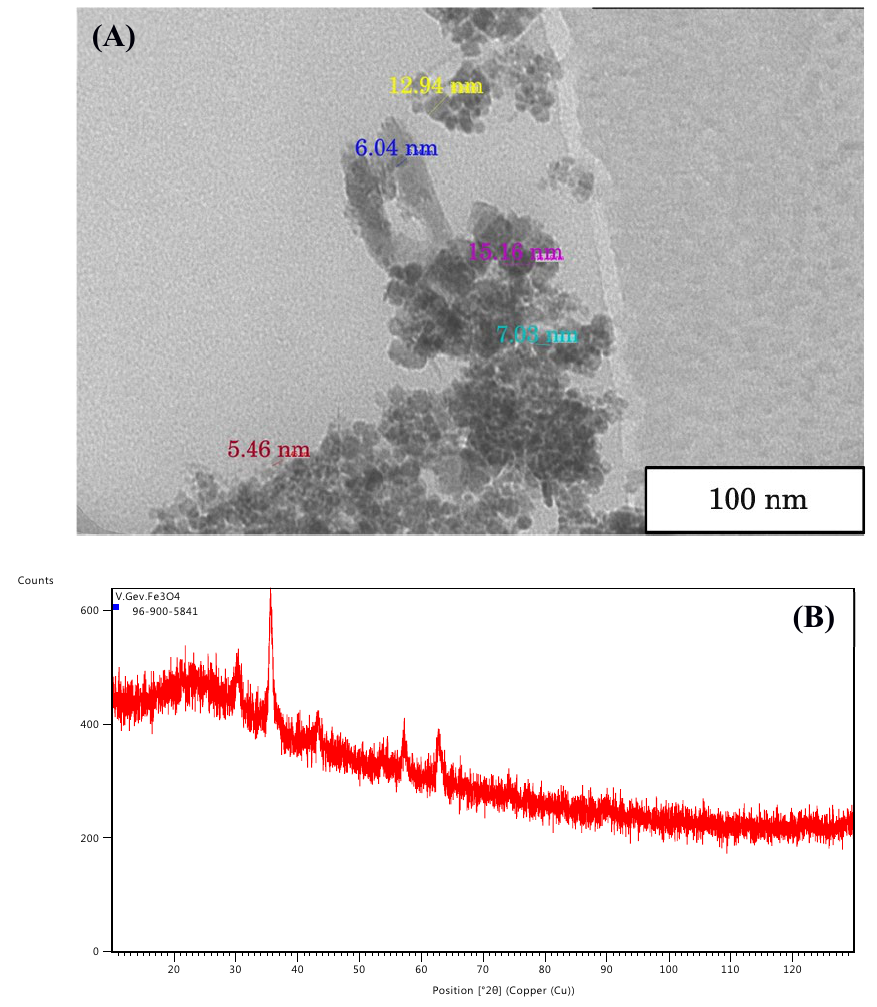
Figure 6. TEM image of synthesized Fe 3 O 4 NP ( A ). The sizes of some nanoparticles indicated immediately in the figure. XRD pattern of the Fe 3 O 4 NPs ( B